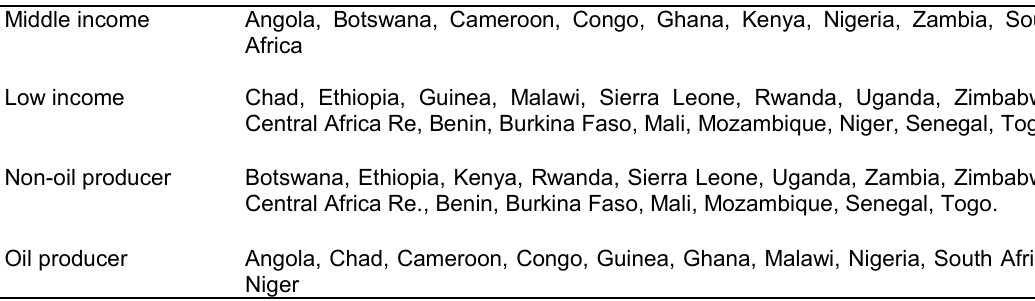
Table A.2 . List of countries by